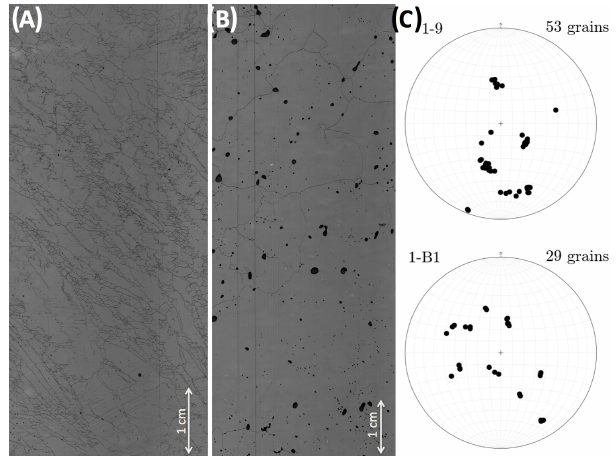
Figure 5. Selected results from microstructural analysis. Two ex- ample images of a large-area scanning macroscope (LASM) of ice samples of profile 1 (block 1-11) and 2 (block 2-7) are shown in (a, b) , respectively. The basal ice of the two profiles looks distinctly different, with large grains and abundant air bubbles dominating profile 2 (b) . In contrast, the lowest 10cm of profile 1 is almost bubble-free and show very small elongated grains (a) , indicating refrozen meltwater (see text). Schmidt diagrams shown in (c) illus- trate the multiple-maxima crystal-preferred orientation of the (non- meltwater) basal